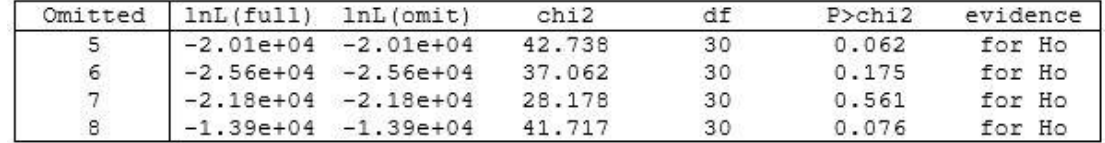
Figure A1. Density of trips to work per hectare. Source: Calculations made with information from Mobility Survey (2015).